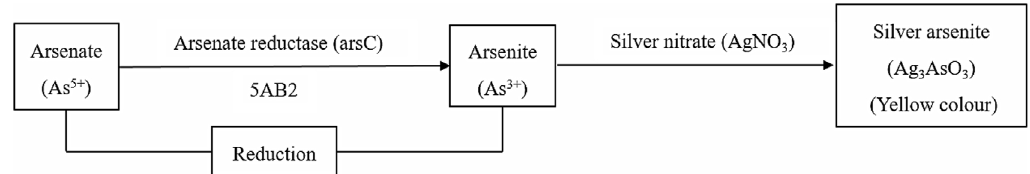
Fig. 3(a). Mechanism of arsenate to arsenite transformation by 5AB2 bacterial isolate